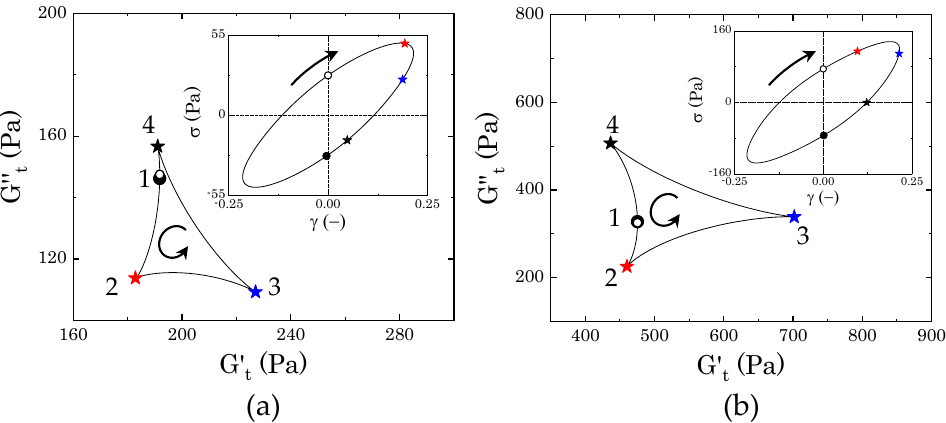
Figure 10. ( a ) Cole–Cole plot obtained at γ 0 = 0.2 (peak of the loss modulus) for sample M0 at 2% wt of Carbopol. ( b ) Cole–Cole plot obtained at γ 0 = 0.2 (peak of the loss modulus) for sample M2 at 2% wt of Carbopol. The insets show the corresponding elastic Lissajous–Bowditch plot (i.e., stress vs. strain) for